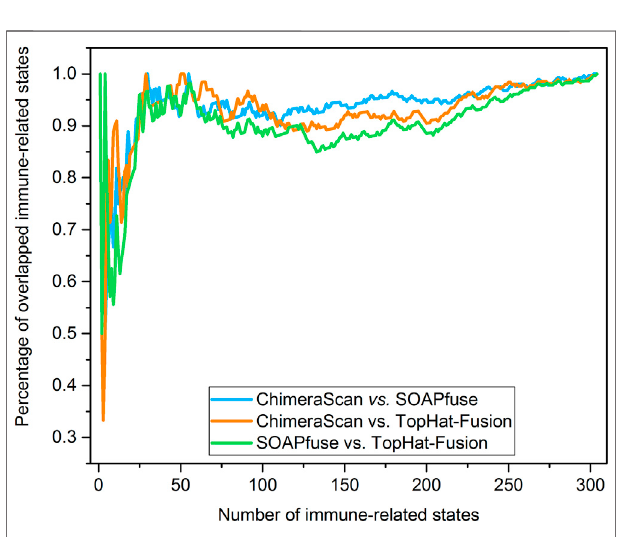
FIGURE 7 | Percentage of overlapped immune-related cell types: the immune-relatedcelltypeswereenrichedandrank-orderedfromhightolowby comparing the DEG regulated by the rede fi ned high-risk subgroup for each fusion detection algorithm and gene signatures of immune-related cell type from ImmGen (https://www.immgen.org/). Then, the percentage of overlapped enriched immune-related was calculated between any two rank- ordered immune-related cell type lists. The top-ten enriched immune-related cell types were illustrated in the sub-table for each fusion detection algorithm.